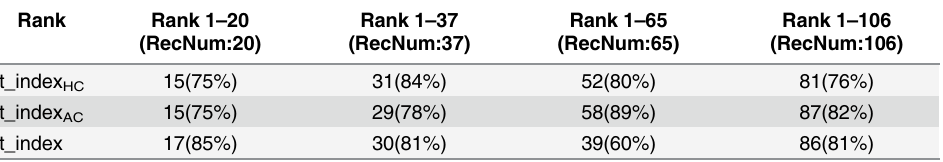
Note: The segments are not separated evenly because tied ranking cases are not uncommon in ranking lists. In each cell, the number means the counts of authors who have the same rank range in both ranking list of h_index and ranking list of t_index, and the percentage in brackets means the percentage of the counts of authors who have the same range in both ranking